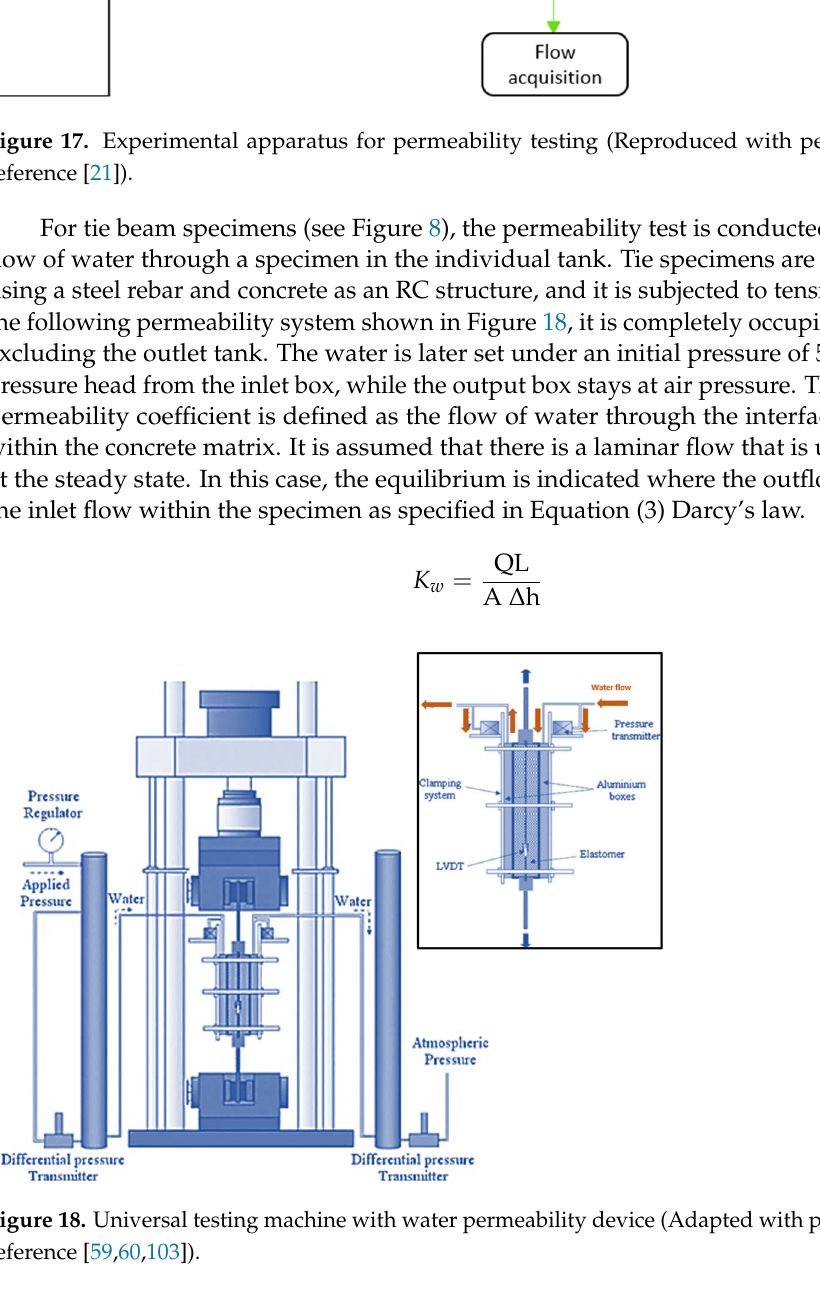
Figure 17. Experimental apparatus for permeability testing (Reproduced with permission from reference [21]).